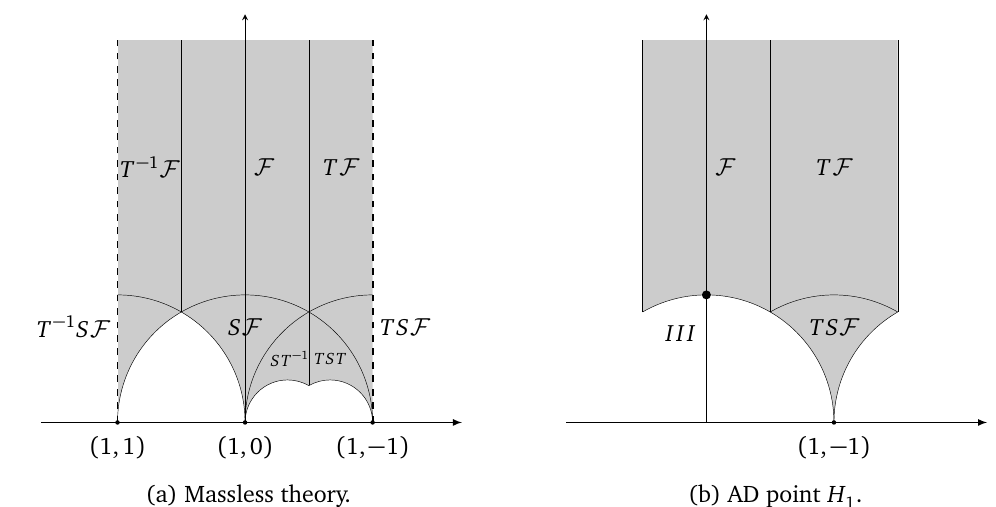
= 2 theory. (a) Choice of funda- Figure 8: Fundamental domains for the 4 d SU ( 2 ) N f = m = 0 with a branch cut structure indicated by the dotted mental domain for m 1 2 lines. The τ = 0, ± 1 singularities are I cusps. (b) Choice of fundamental domain for 2 the configuration involving a type- I I I singularity. Three BPS states become massless at the point at τ = i